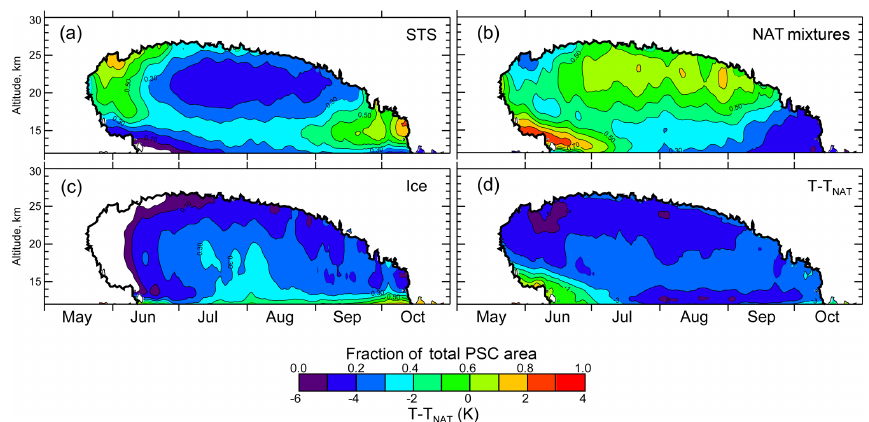
Figure 16. Twelve-year mean relative spatial coverage (composition-specific area normalized by total PSC area) for (a) STS; (b) NAT mix- tures, including enhanced NAT mixtures; and (c) ice, including wave ice. For additional perspective, (d) shows the 12-year mean distribution of T − T NAT . The thick black contour line on each of the color panels corresponds to the range of days and altitudes where PSCs (of any composition) were observed in at least 6 of the 12 Antarctic seasons.